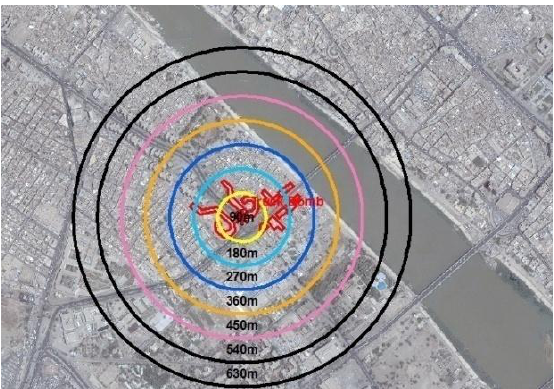
Fig. 13: The rings of blast wave effect damage show the yellow track represented the probable lethal injuries, the three rings later represented damage, and the rings remain represented probable injuries.